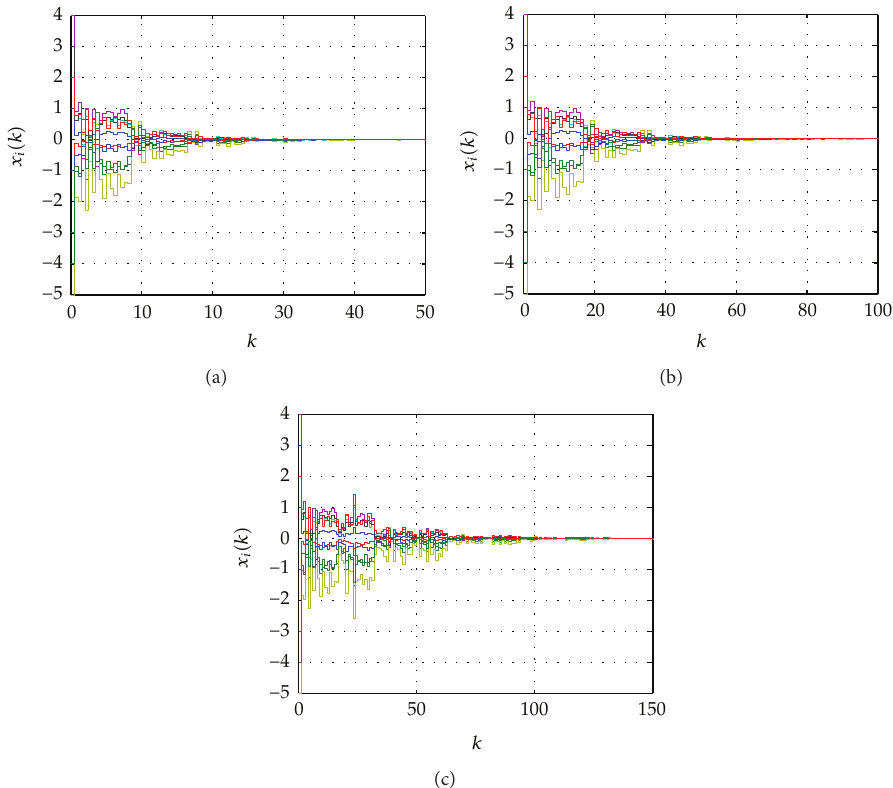
Figure 2: State responses with C1-1 (Example 10): (a) 𝜏 = 3 , (b) 𝜏 = 15 , and (c) 𝜏 = 30 .